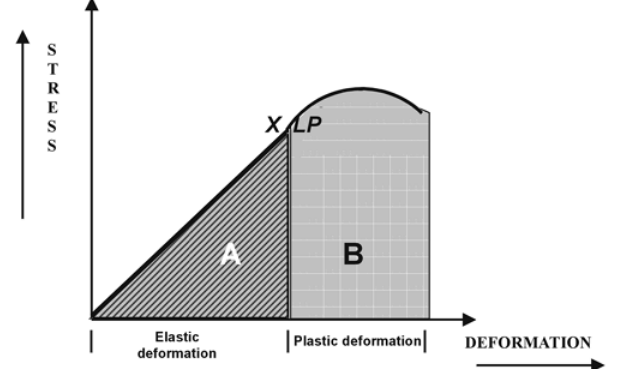
FIGURE 3- Areas indicating resilience (A) and toughness (A+B) of a material